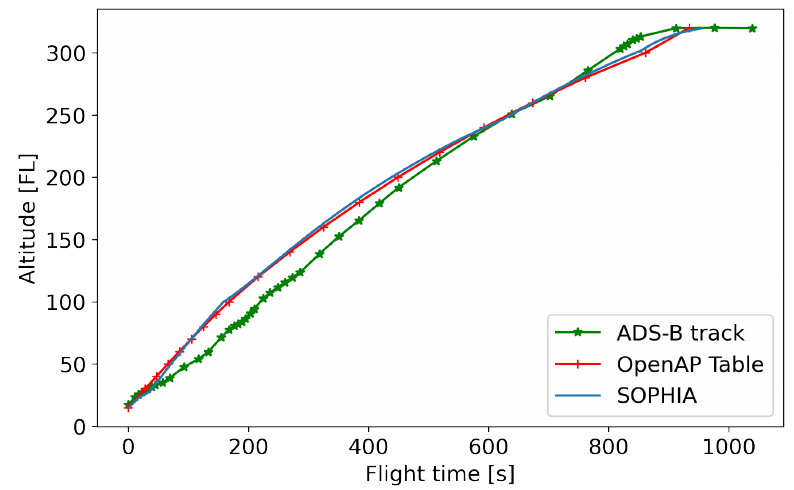
Figure 2. Comparison of the vertical profile from the ADS-B track data (green) with the OpenAP performance tables (red) and the optimization of SOPHIA (blue) of the same aircraft